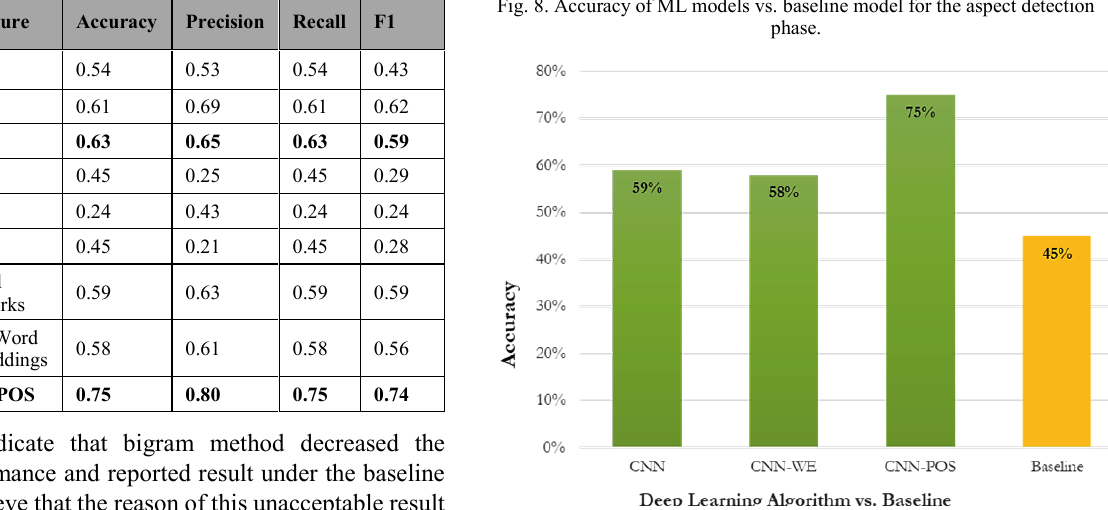
Fig. 9. Accuracy of DL models vs. baseline model for the aspect detection